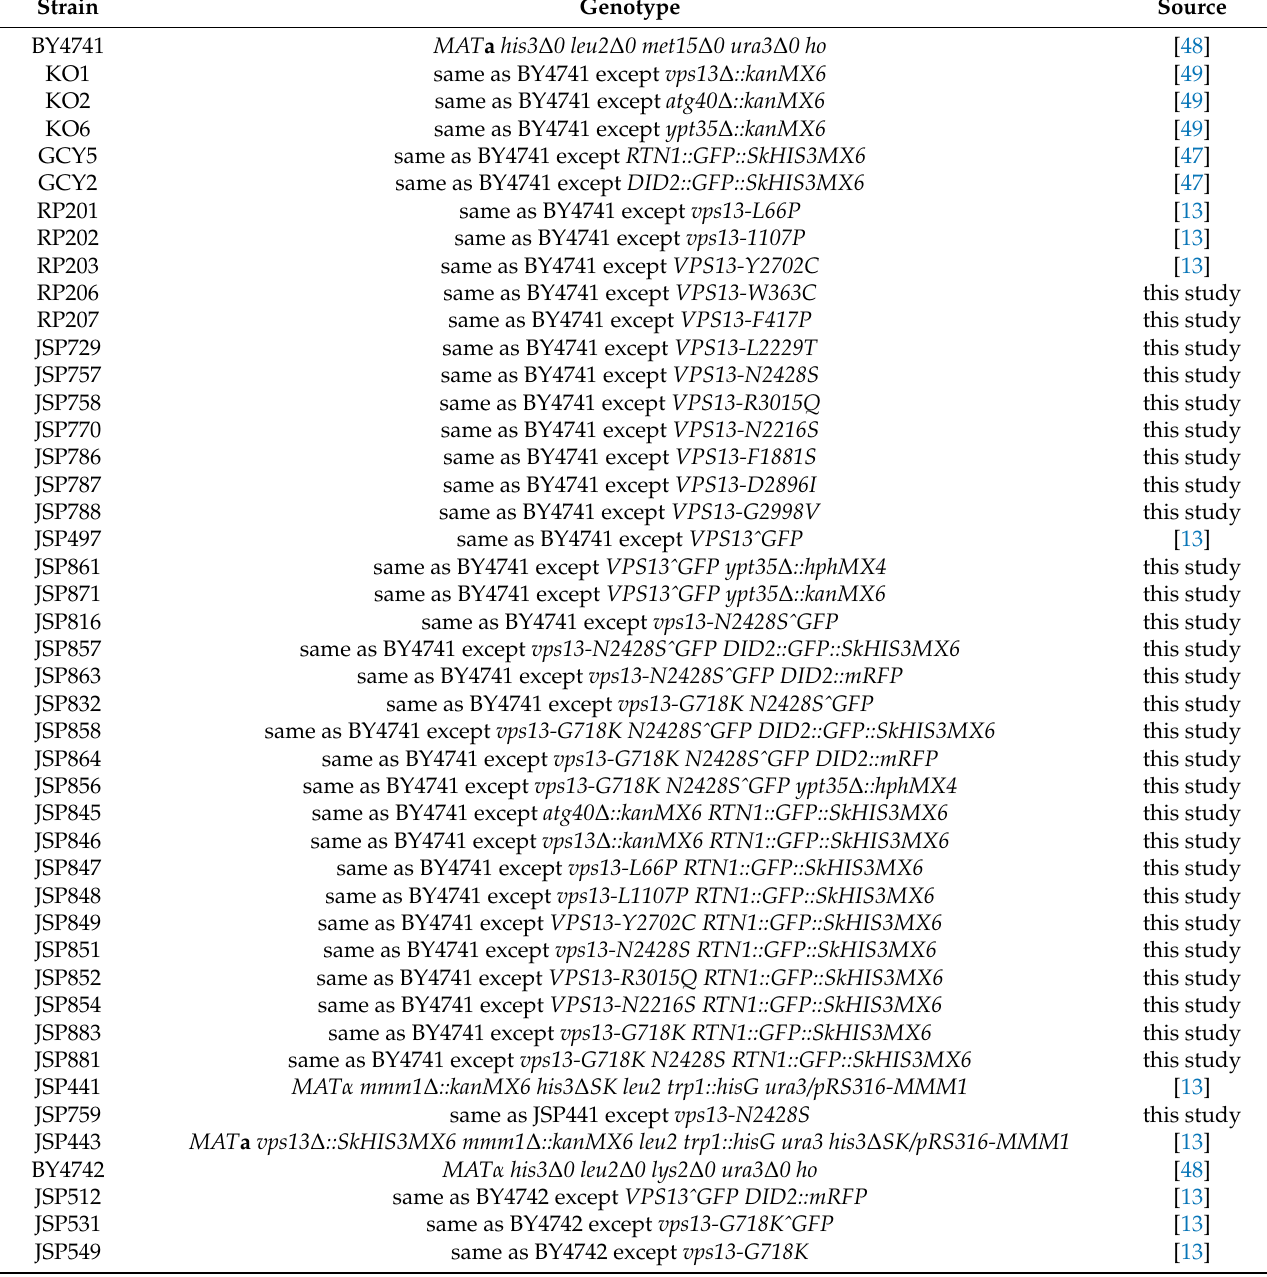
Table 3. S. cerevisiae